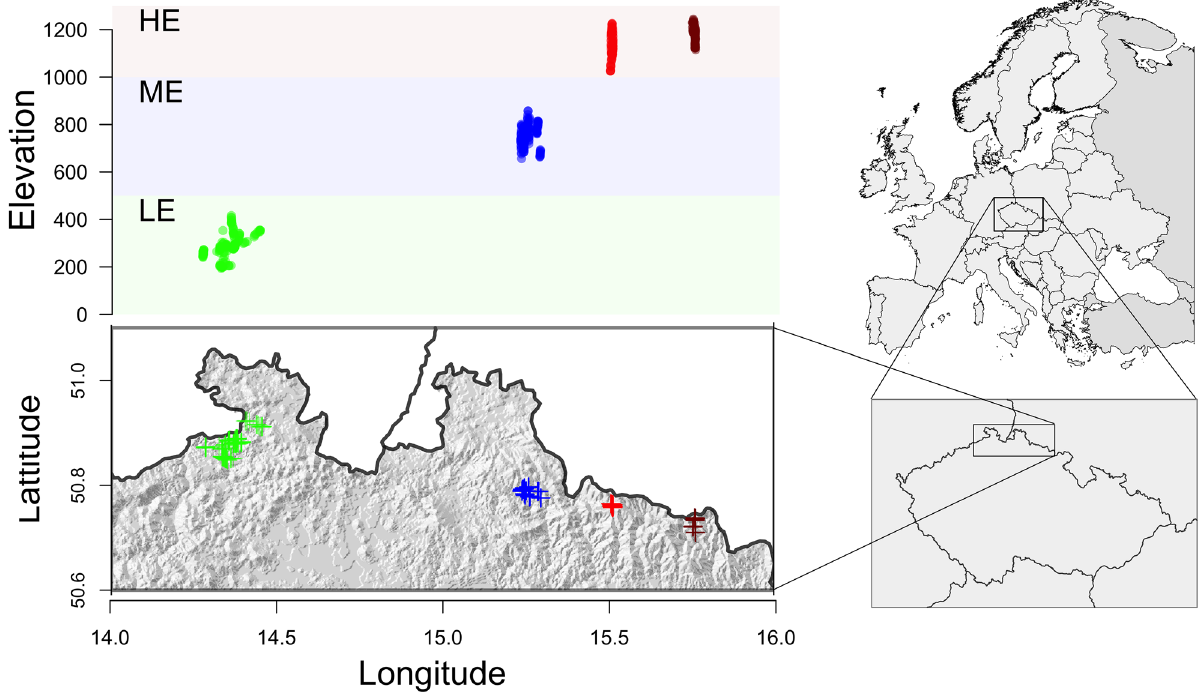
Figure 1. Location of sampling areas. Maps were prepared with R packages raster (v3.5-2) 53 and RCzechia (v1.8.3) 54 , lines were added using GIPM software 55 . Low-elevation (LE) ecotype (green), medium-elevation (ME) ecotype (blue), and high-elevation (HE) ecotype subplot 1 (red) and subplot 2 (brown).